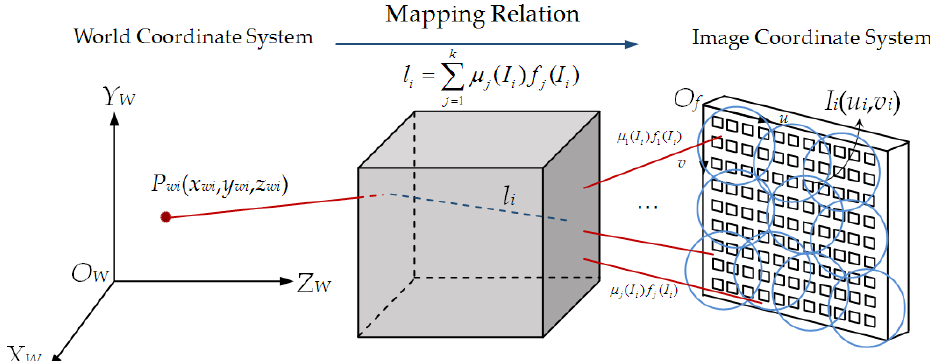
Figure 2. The diagram of mathematical model of the orthogonally splitting imaging pose sensor based on KDFcmPUM. In the figure, KDFcmPUM is the abbreviation of the partition of unity method based on KDFcm).